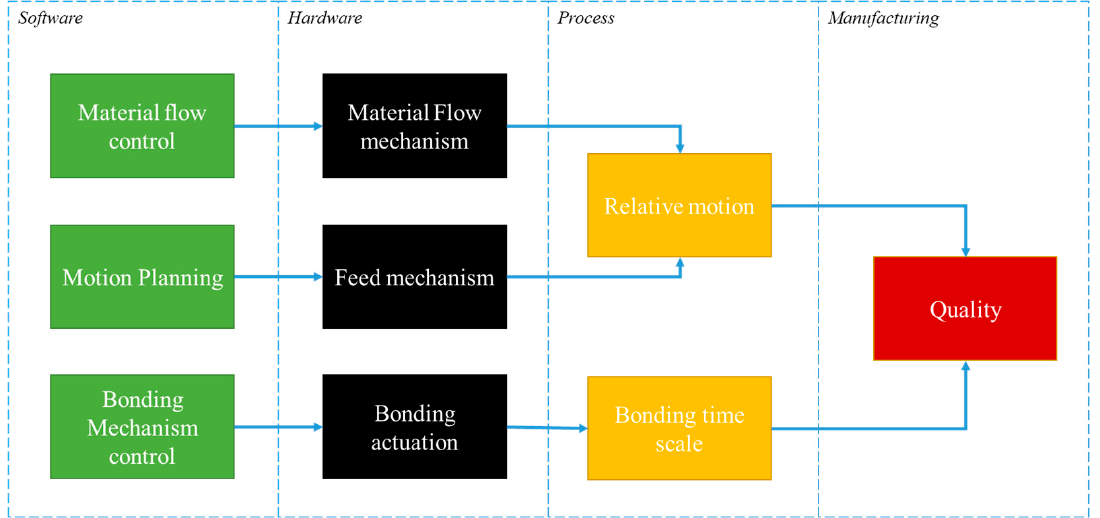
Figure 5. Abstractive metamodeling in AM.